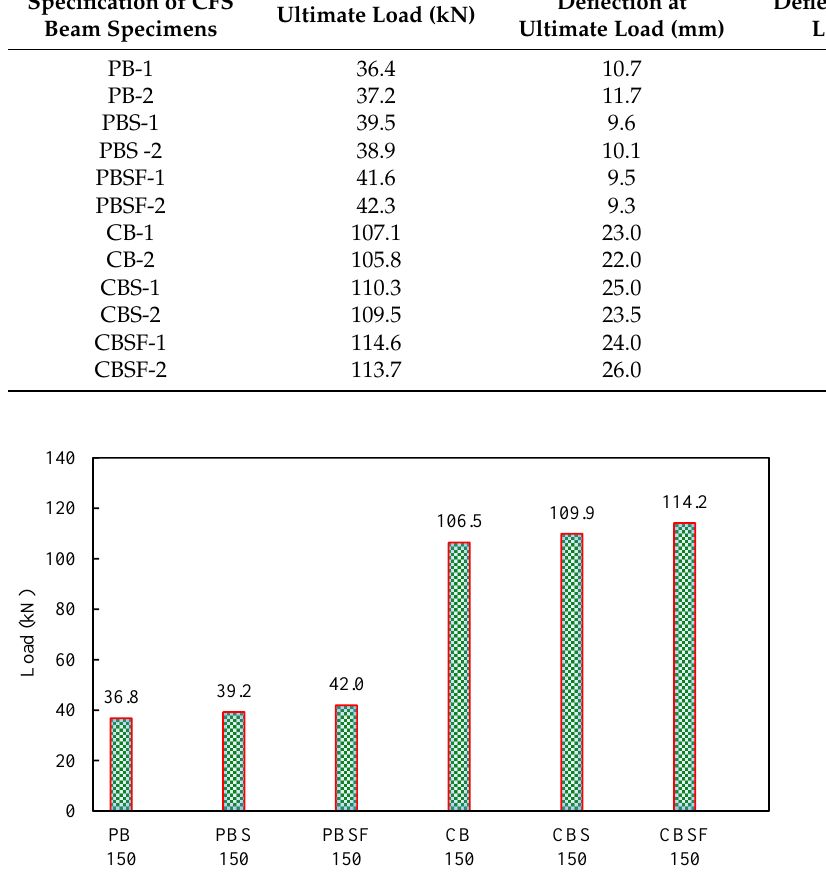
Figure 8. Comparison of the load capacities of the CFS beams. Table 2. Load – deflection results .